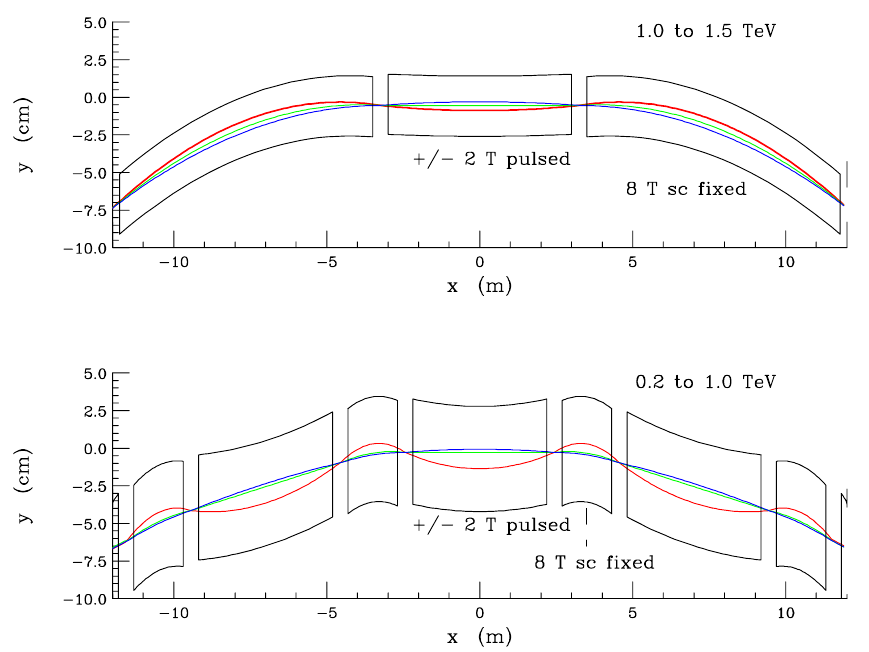
FIG. 38. (Color) Schematic of hybrid superconducting-pulse magnet accelerator